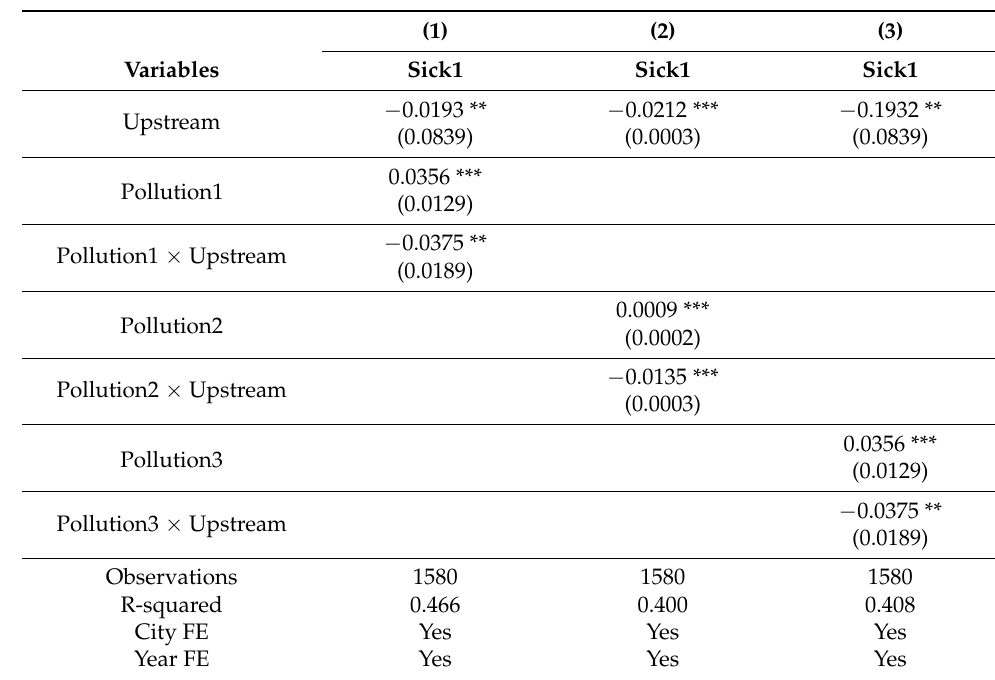
Table 7. Effect of pollutant emissions on residents’